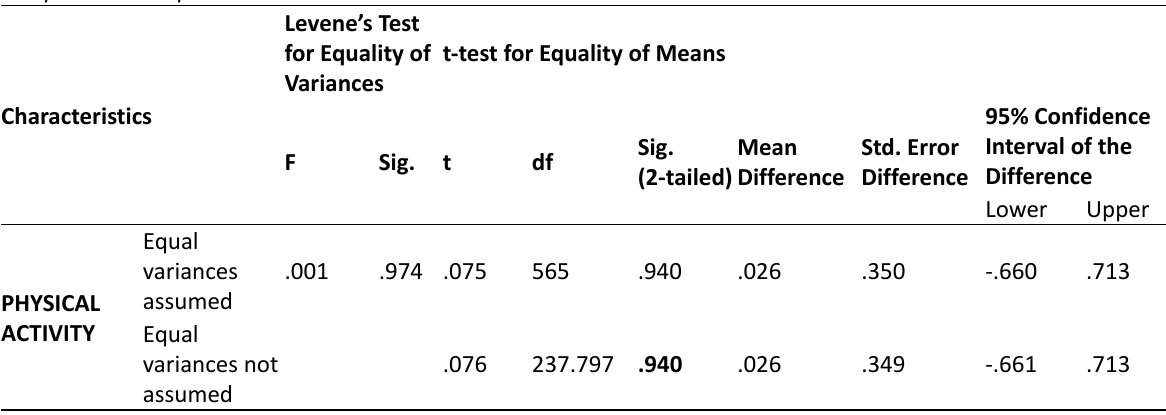
Table 5. Results regarding adherence to the MD and PA for all students involved in the study PHYSICAL ACTIVITY Characteristics